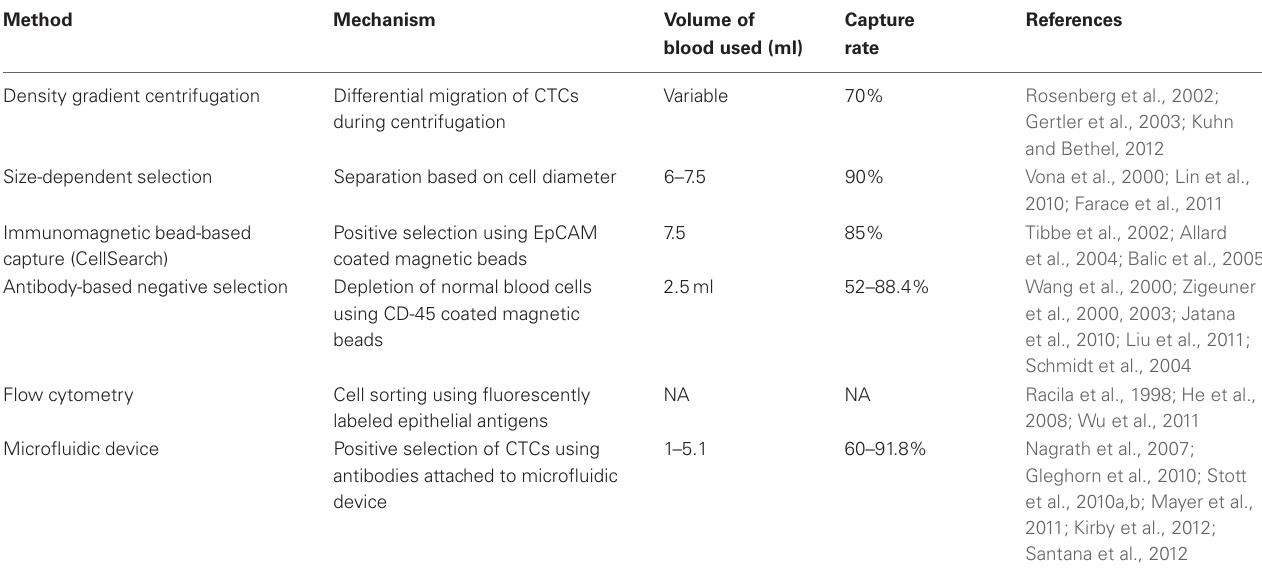
Table 1 | Summary of techniques used to isolate prostatic